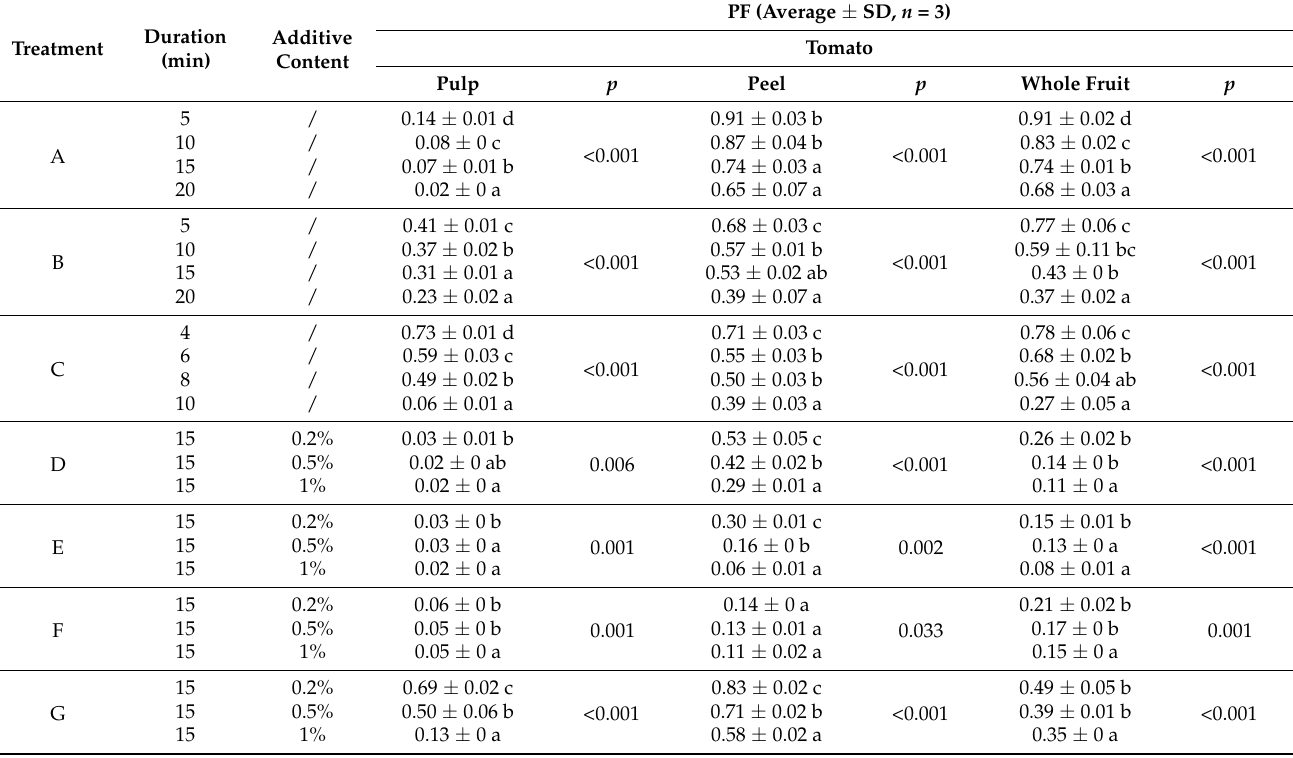
Table 2. PF values of racemic penthiopyrad in tomato samples after different soaking